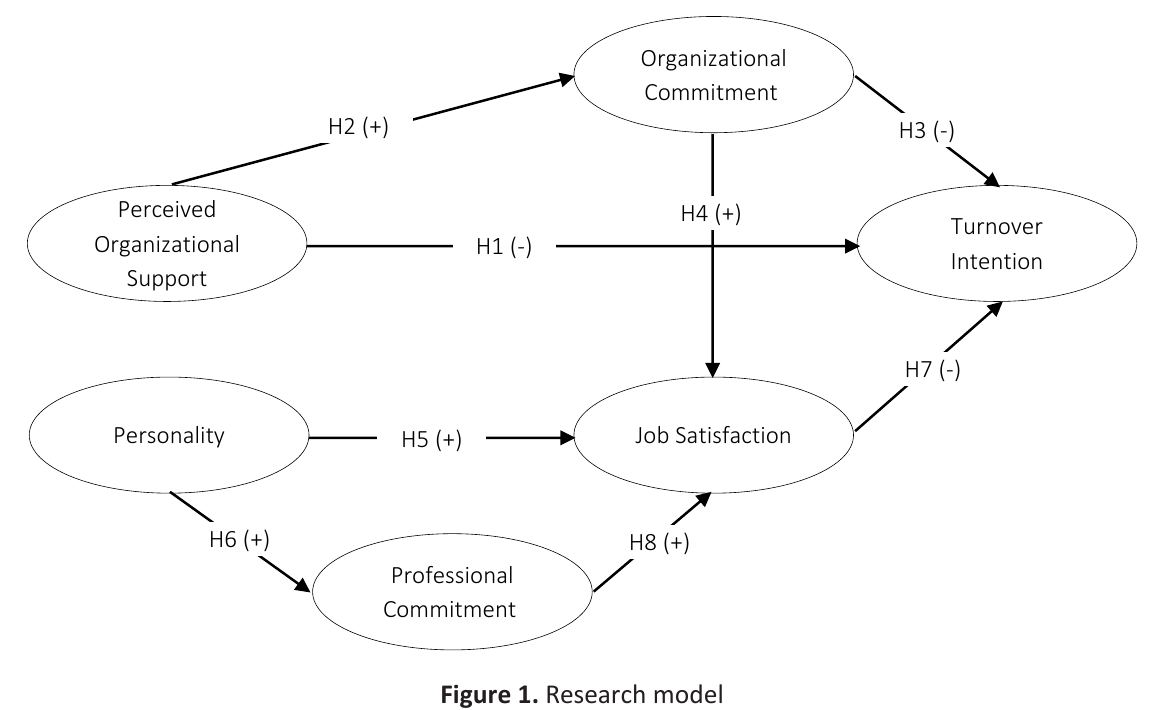
Figure 1. Research